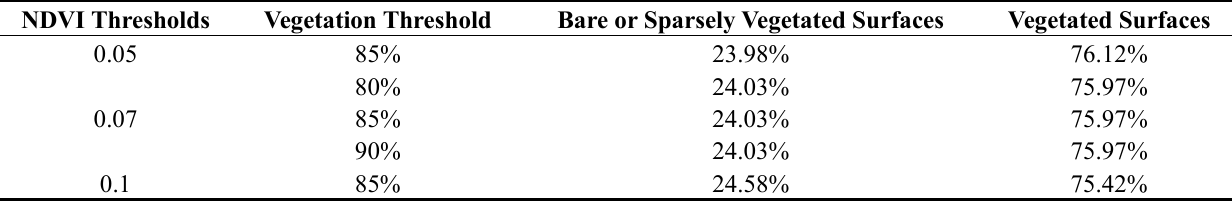
Table 5. Percentage of pixels belonging to the categories “Vegetated” and “Bare or Sparsely vegetated” surfaces depending on the NDVI and vegetation threshold. NDVI Thresholds Vegetation Threshold Bare or Sparsely Vegetated Surfaces Vegetated Surfaces